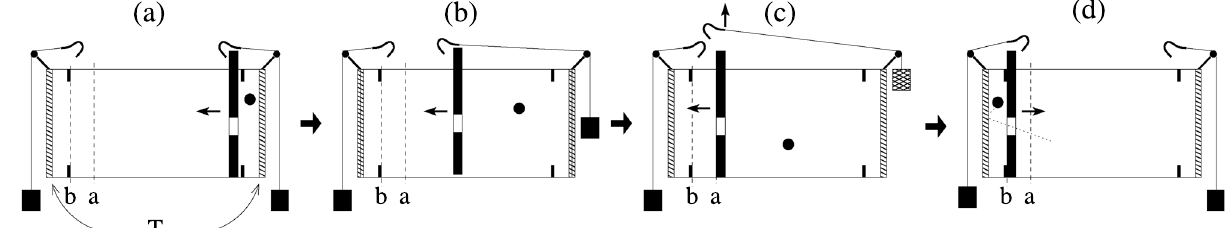
Figure 1. Schematic of the engine with porous piston. ( a ) The piston is initially connected to the right load mass and the particle bounces between the right thermal wall and the piston. ( b ) The particle pushes the piston to the left. ( c ) Once the piston gets to position a , the high energy load mass hanging from its right is removed and a new low energy one is placed on the right end of the container. ( d ) As the piston gets to point b it couples with the left load mass. Once the particle crosses to the left side through the pore it will push the piston to the right and the cycle